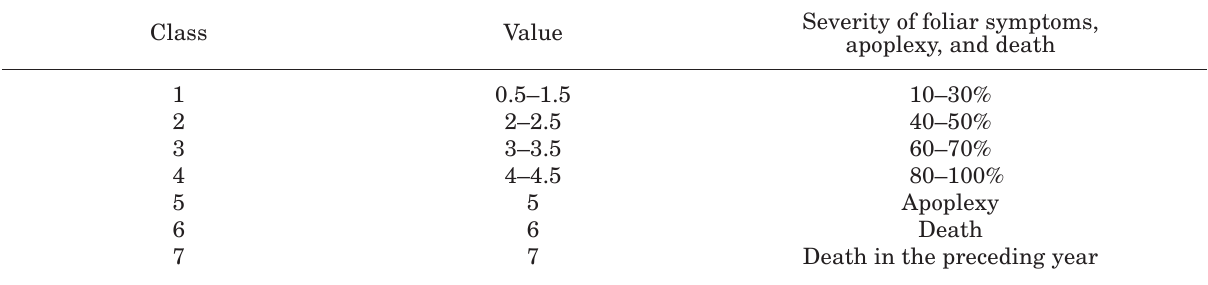
Table 1. Scale used for classification of grapevines in relation to the severity of foliar symptoms, apoplexy, or death. Class